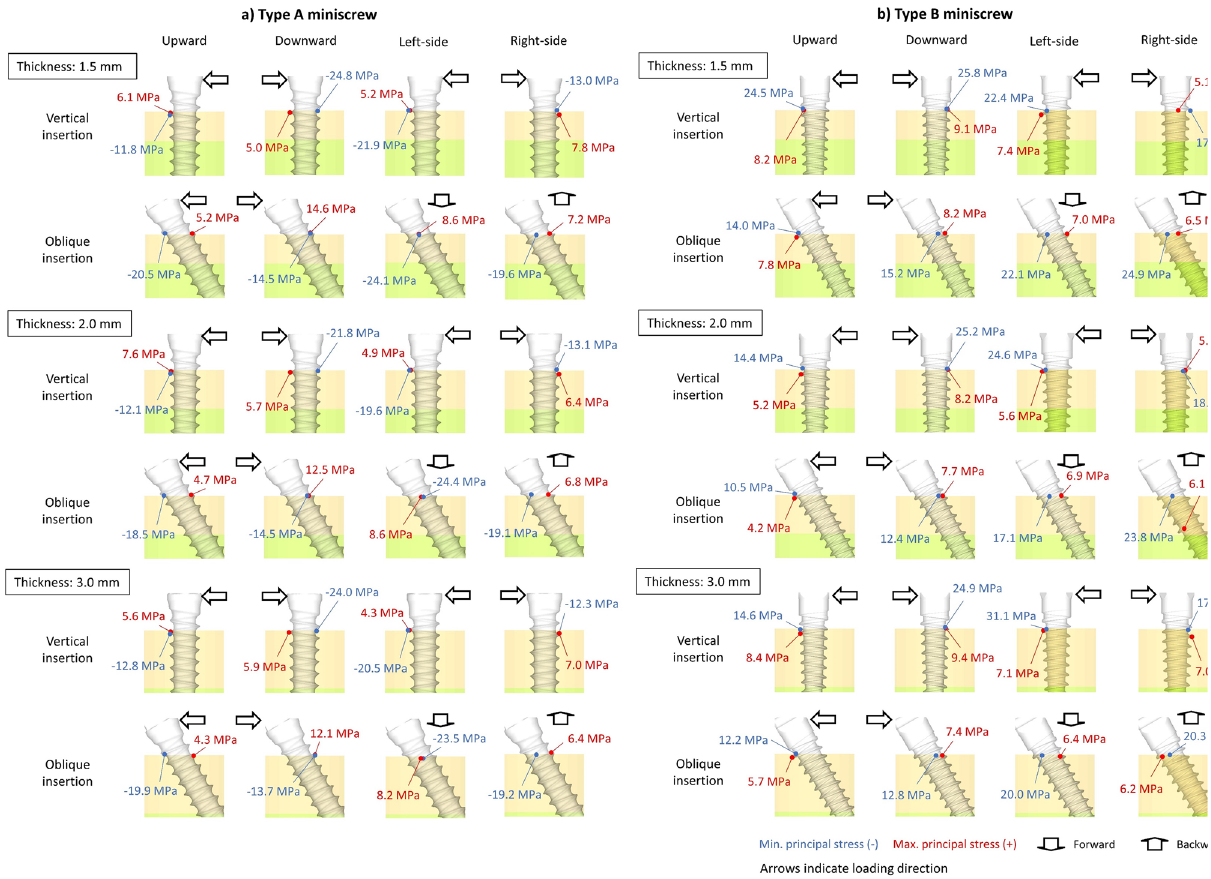
Figure 4. Schema of greatest maximum and smallest minimum principal stresses on the surface of cortical bone when the miniscrew was placed vertically or obliquely in each cortical bone thickness. ( A ) Type A miniscrew, ( B ) Type B miniscrew. Arrows indicate the loading